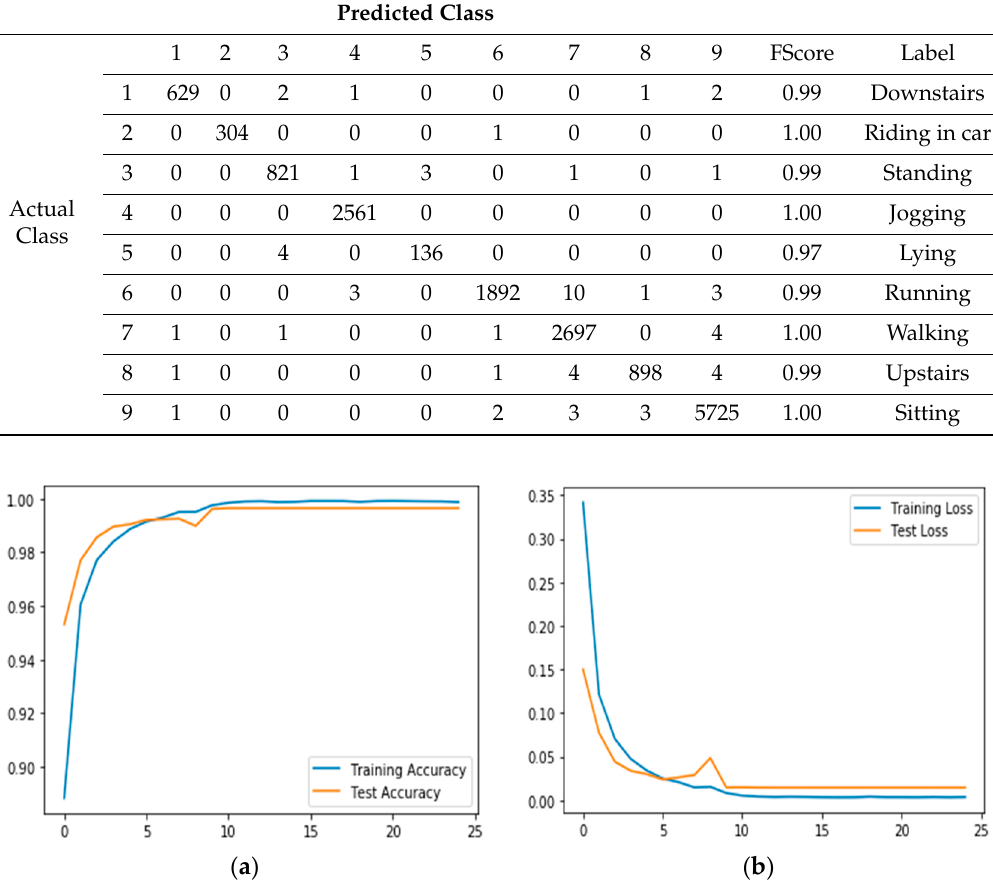
Figure 23. Training accuracy ( a ) and loss performance ( b ) of Inertial + Ambient sensing data. Table 3. Confusion Matrix for Inertial + Ambient Sensing .